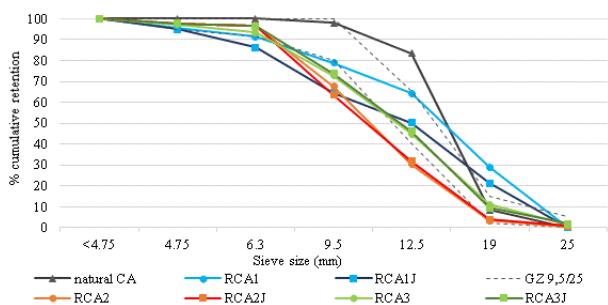
Figure 3. Granulometric curves of recycled coarse aggregates from sources 1, 2 and